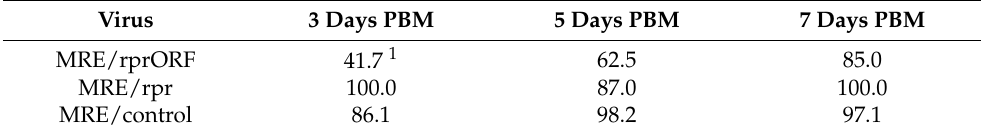
Table 1. Dissemination rates at different days